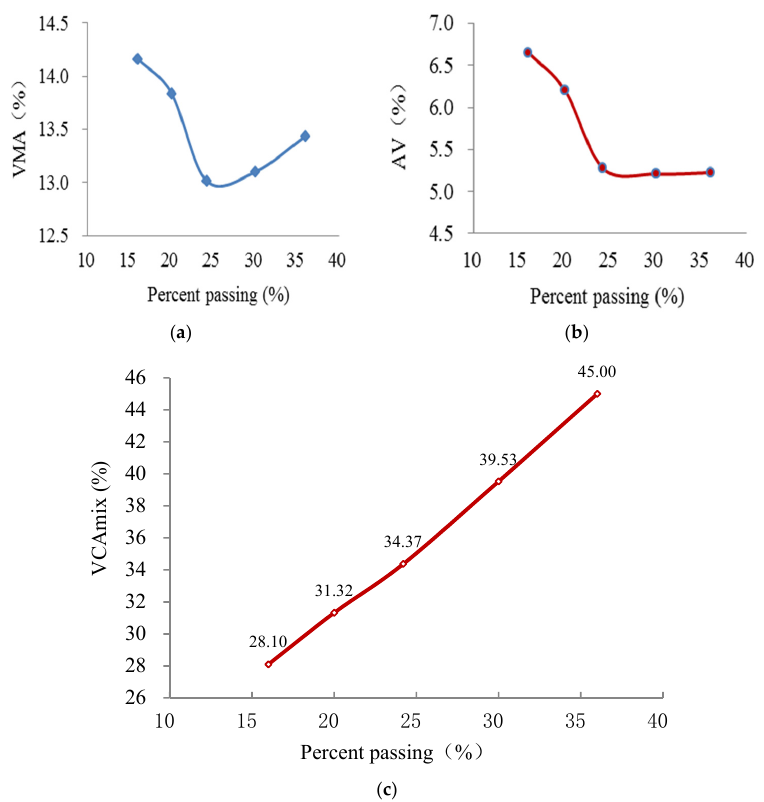
Figure 8. VPs of AC-25 samples versus PP. ( a ) VMA; ( b ) AV; ( c ) VCAmix.